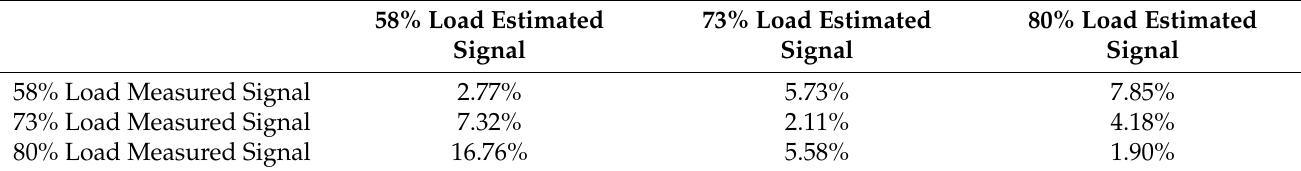
Table 5. Residual RMSE comparison of gear-to-gear transmission measured signal and estimated signal based on the load